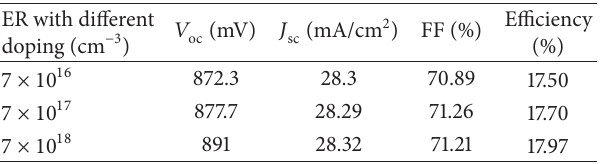
Figure 8: Effect of ER layer thickness on open-circuit voltage of the cell. A doping of 7 × 10 16 cm −3 is assumed. Table 4: ER layer with different values of doping density. Thickness of ER layer is